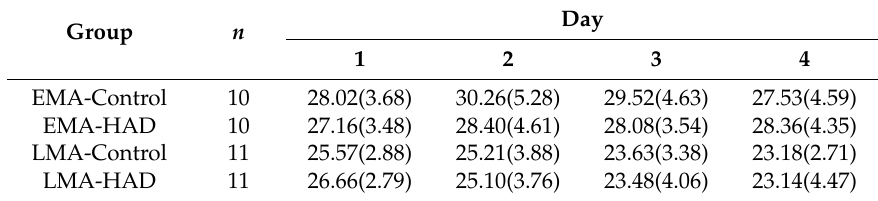
Table 1. Mean speed 1 (standard deviation in parentheses) across training days by condition. Day Group n 1 2 3